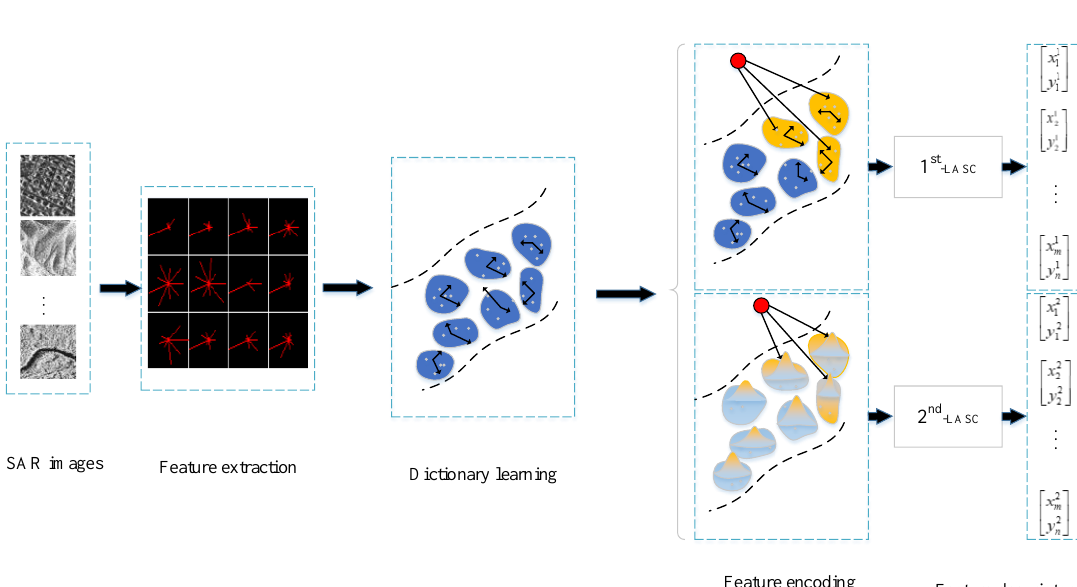
Figure 3. The illustration of the traditional LASC method. The LASC features are extracted by hand crafting, such as the histogram of oriented gradient (HOG) [36], and the dictionary of LASC is an ensemble of low-dimensional linear subspaces attached to the affine subspaces.